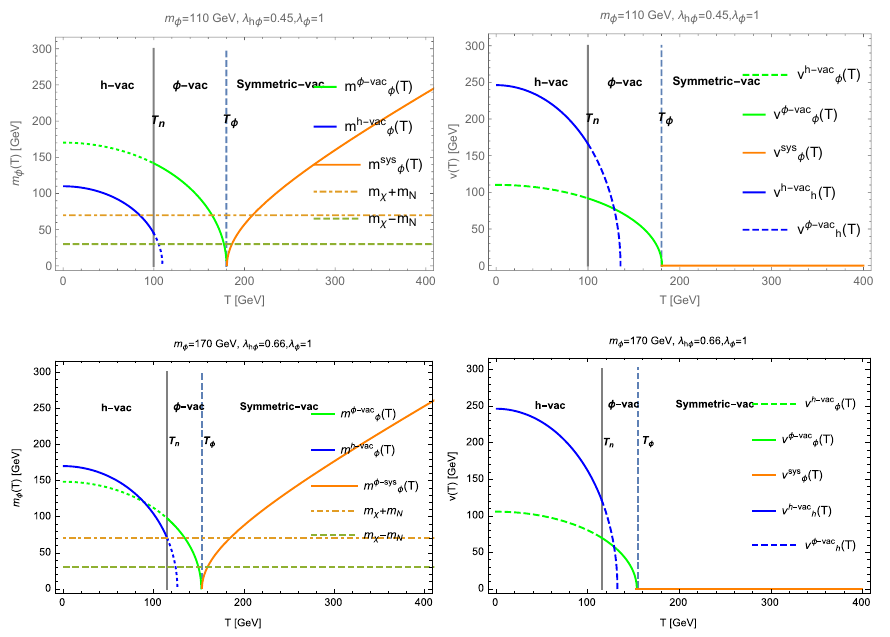
Figure 5 . The thermal corrected mass evolution of (cid:30) and the evolution of the VEVs versus temperature (T) for m (cid:30) = 110 GeV (to be studied in (cid:12)gure 6 and the top-panel of (cid:12)gure 7), m (cid:30) = 170 GeV (to be studied in (cid:12)gure 8). is generated, while the freeze out mechanism can also contribute signi(cid:12)cantly when the (cid:30) couples with the SM Higgs moderately for a successfull SFOEWPT. One can simplify the evaluation of the relic density of the (cid:30) from the two contributions, one from freeze-out and the other from the late decay of (cid:31)